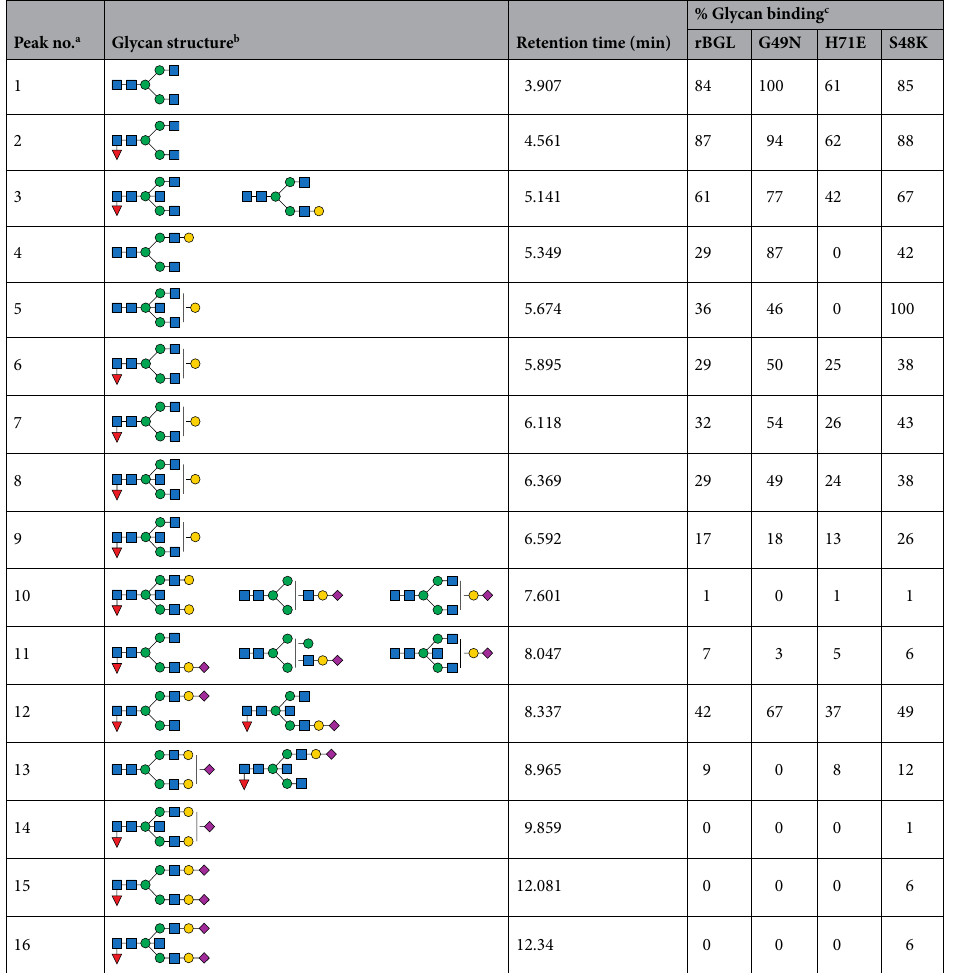
Table 1. Human IgG N -glycans captured by EDGE UPLC-HILIC-FLR profiling with various BGLs. a A complex mixture of 2AB-labeled human IgG N -glycans was subjected to EDGE sample preparation and UPLC- HILIC-FLR profiling to visualize 16 chromatography peaks that are known to each contain single or multiple N -glycan structures. b Sugar symbols are as shown in Fig. 2 c The percentage of each initial chromatography peak area that is recovered after lectin enrichment. It is calculated as described in “Materials and methods”